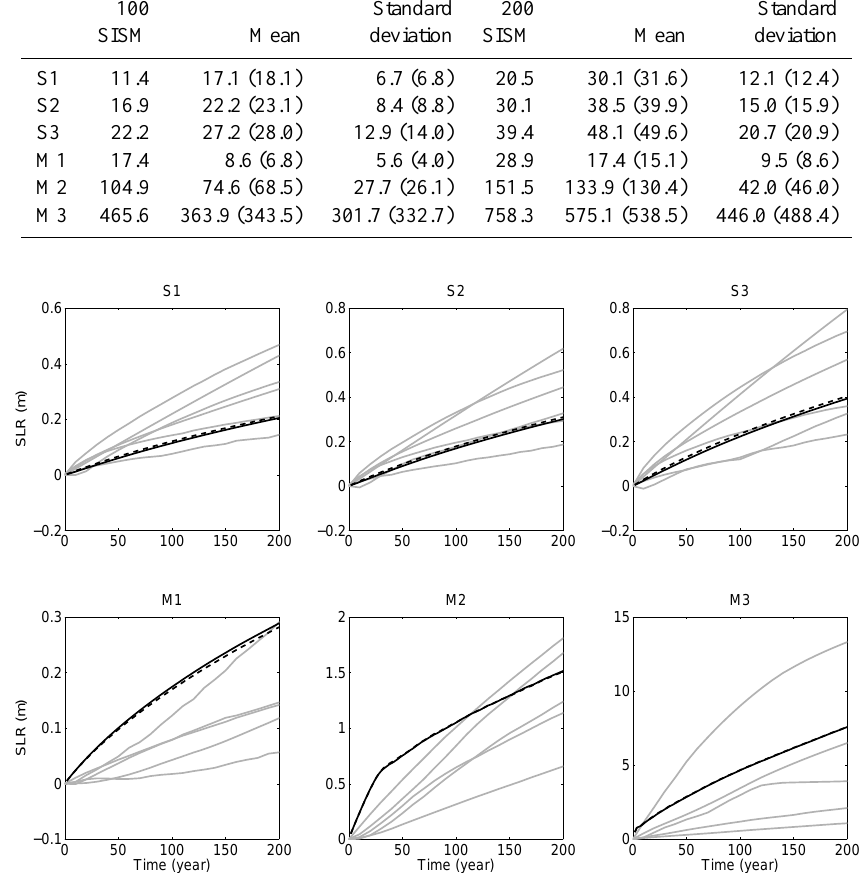
Figure 3. Evolution of the contribution to SLR for all the models participating in SeaRISE experiments S1, S2, S3, M1 M2 and M3 (gray lines). SLR contribution computed by SISM for similar perturbations are presented in black, after a 1000- and 100-year spin-up (continuous and dashed line,